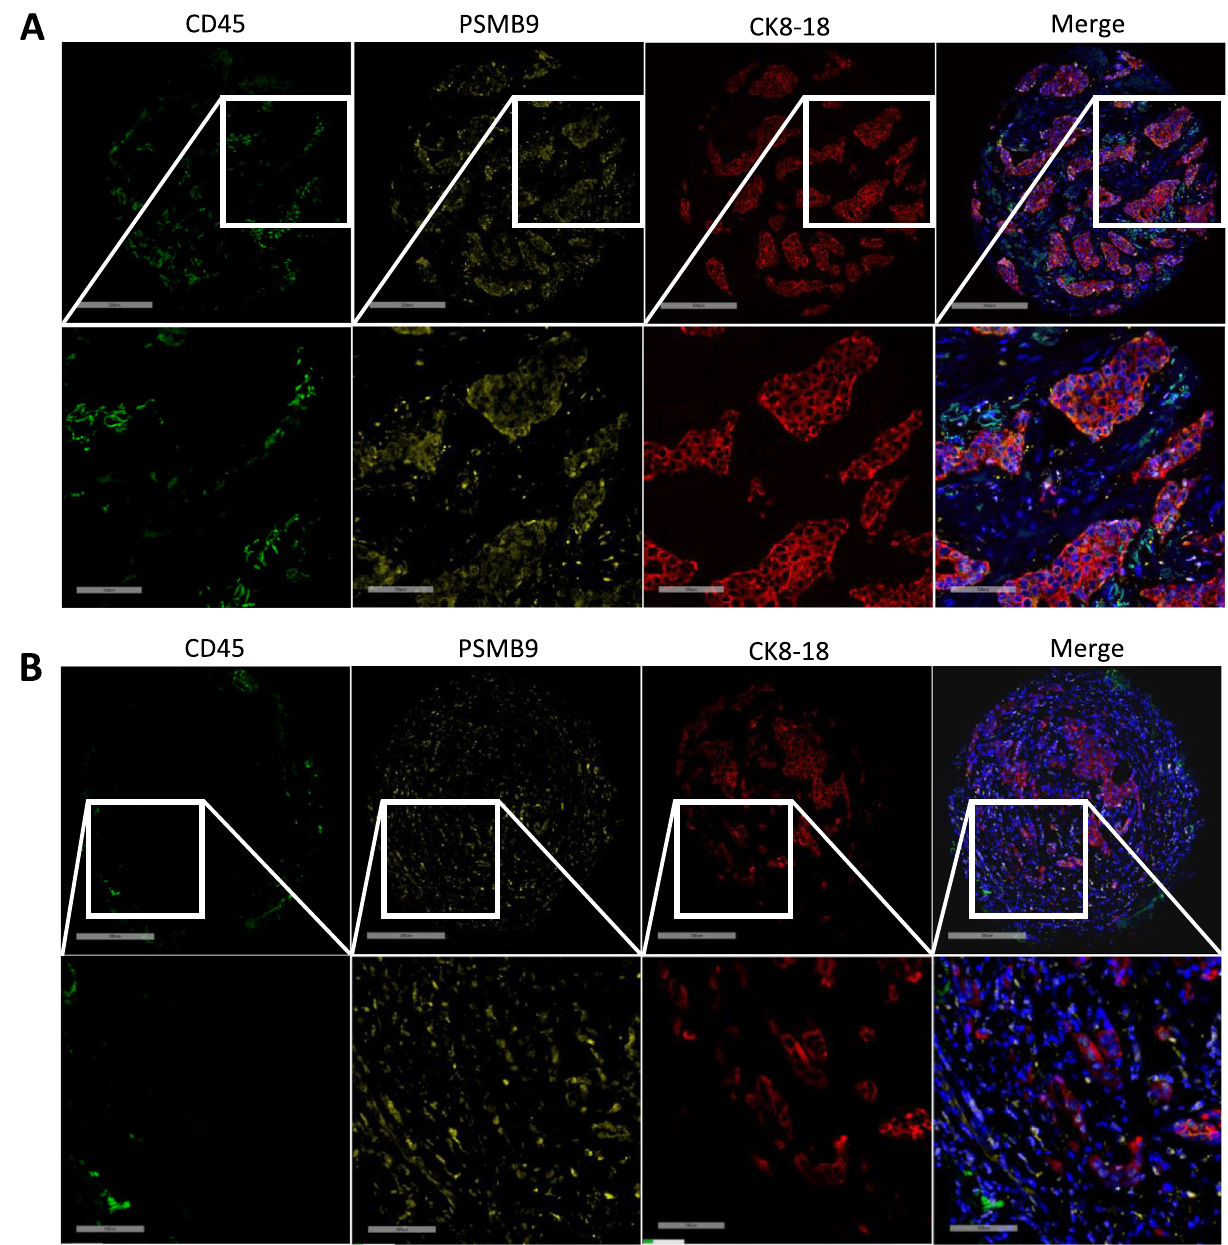
Figure 4. Breast cancer samples have heterogeneous degrees of CD45-positive cells infiltration. IF images of breast cancer samples stained with PSMB9 (yellow), CD45 (green), CK8-18 (red) and DAPI (blue). The images show representative samples containing ( A ) high or ( B ) low CD45-positive cells infiltration. Upper panels show the whole sample cores and lower panels are magnifications of the regions delineated by white squares. Whole core scale bar = 300 µm, close-up scale bar = 100